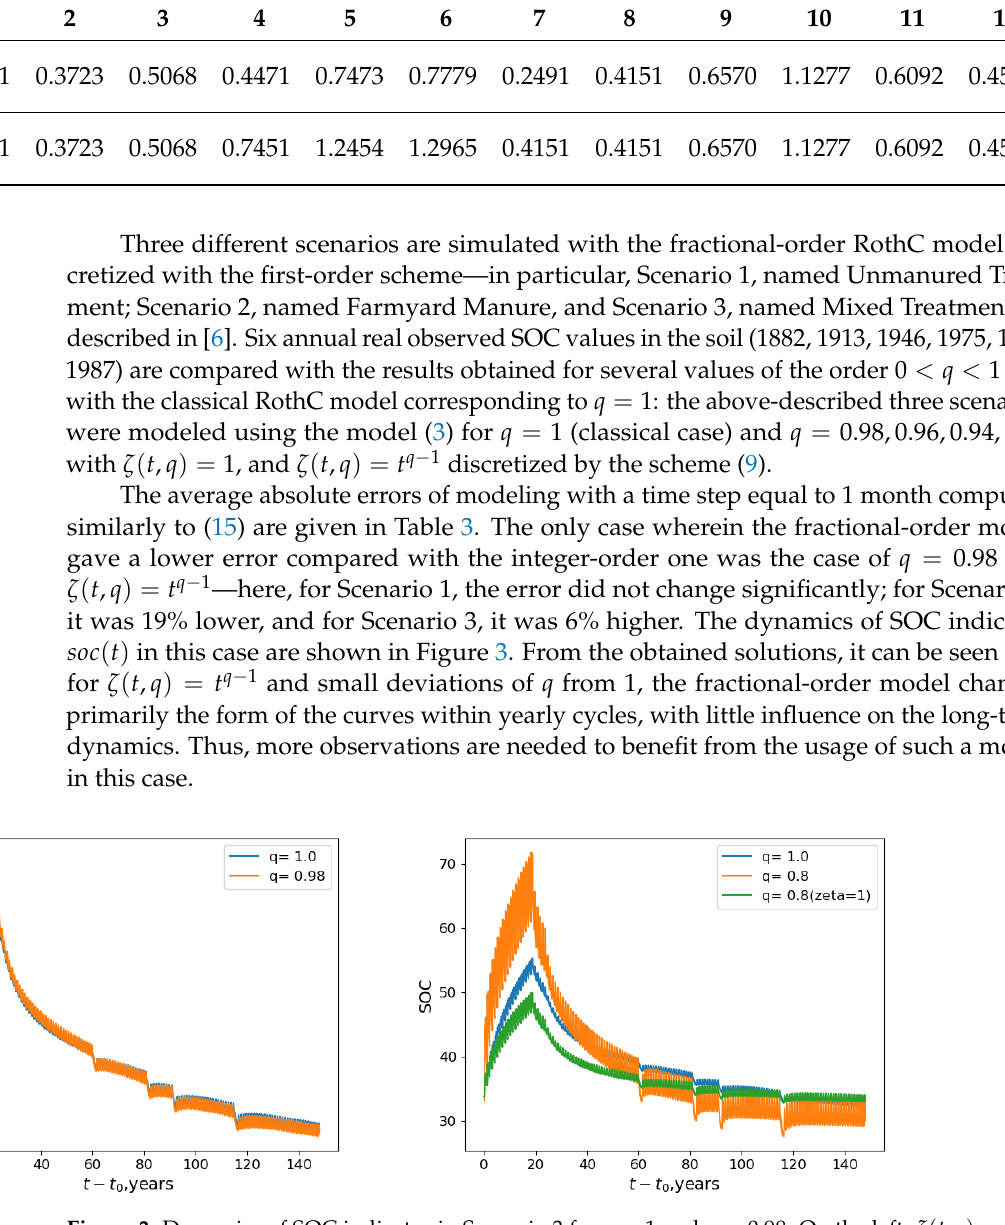
Figure 3. Dynamics of SOC indicator in Scenario 3 for q = 1 and q = 0.98. On the left: ζ ( t , q ) = t q − 1 . On the right: ζ ( t , q ) = t q − 1 (default), ζ ( t , q ) =